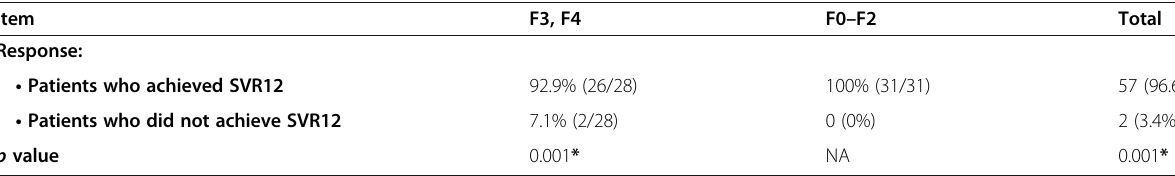
Table 2 Virological response in the study group